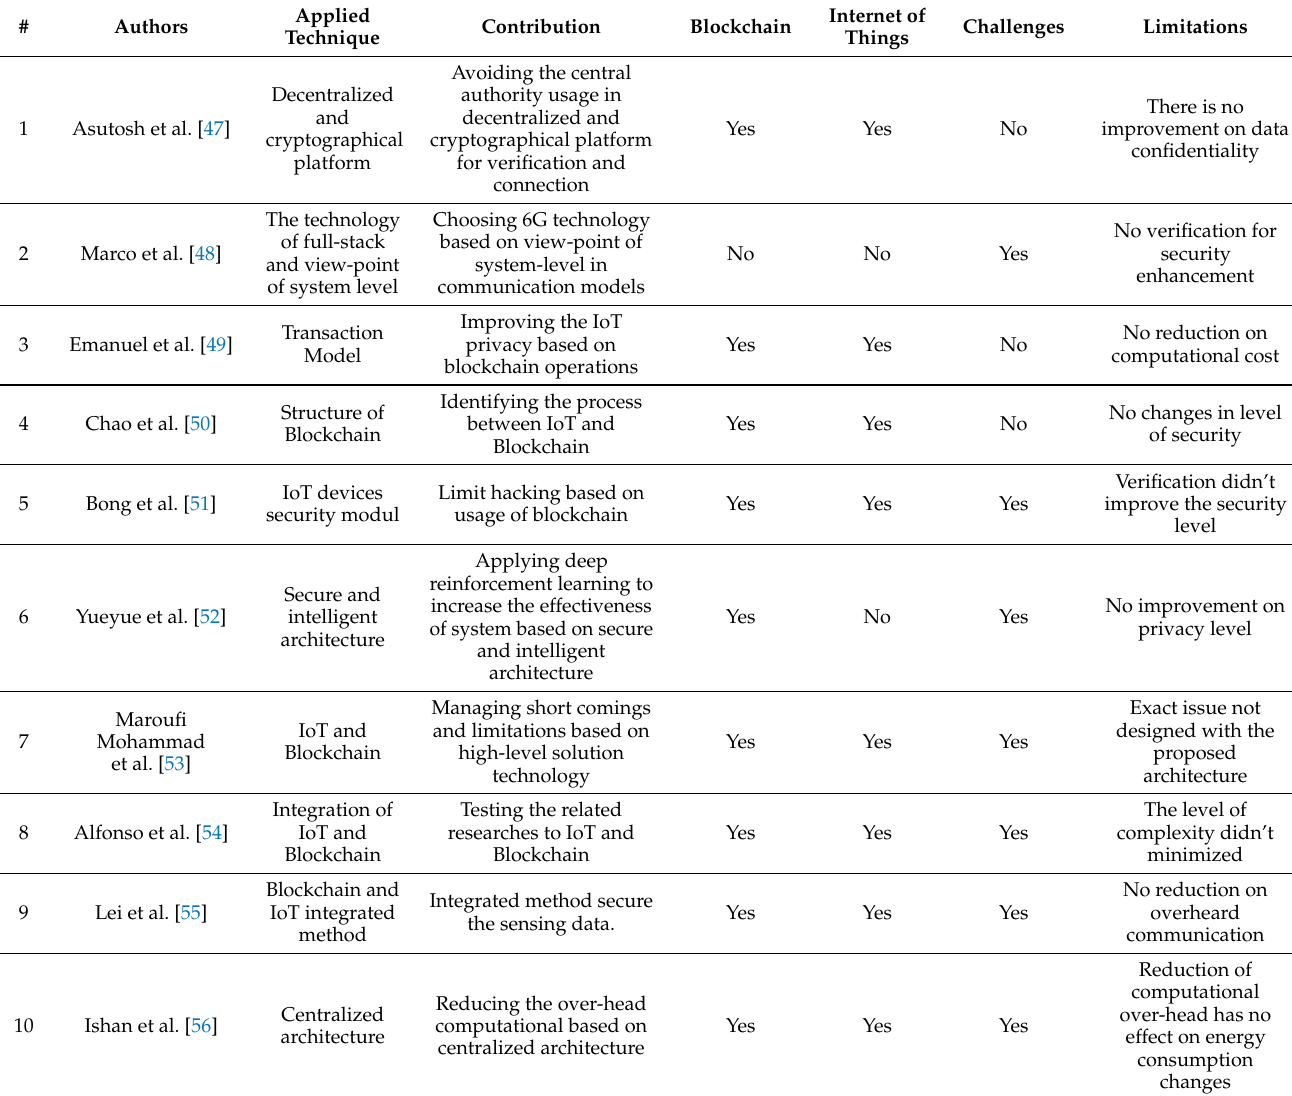
Table 2. Challenges of blockchain and IoT integrated